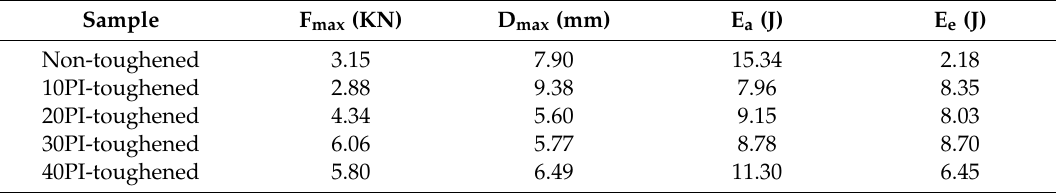
Table 1. Parameters obtained from low velocity impact